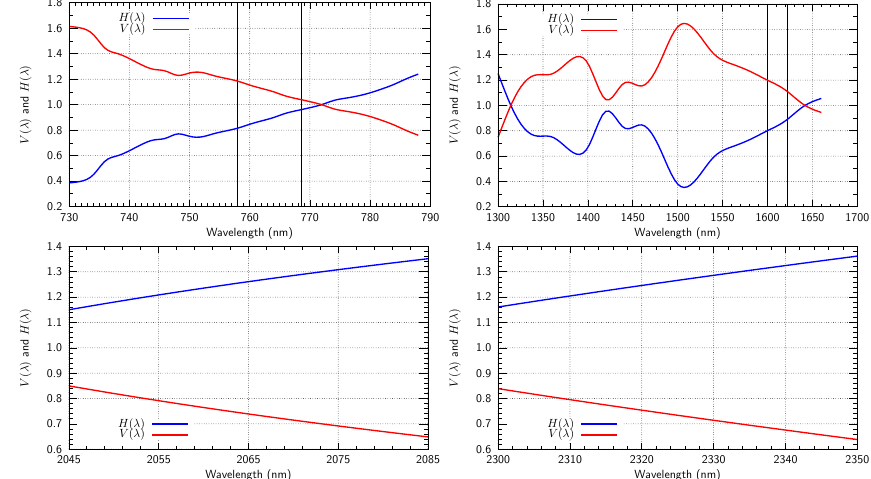
Figure 6. Functions V (λ) and H(λ) for the gratings, measured in the O 2 A-band and weak CO 2 band, and predicted in the strong CO 2 band and CO band. There are two gratings, each used in two orders of diffraction to serve two bands. The vertical lines define the O 2 A-band and CO 2 weak band.